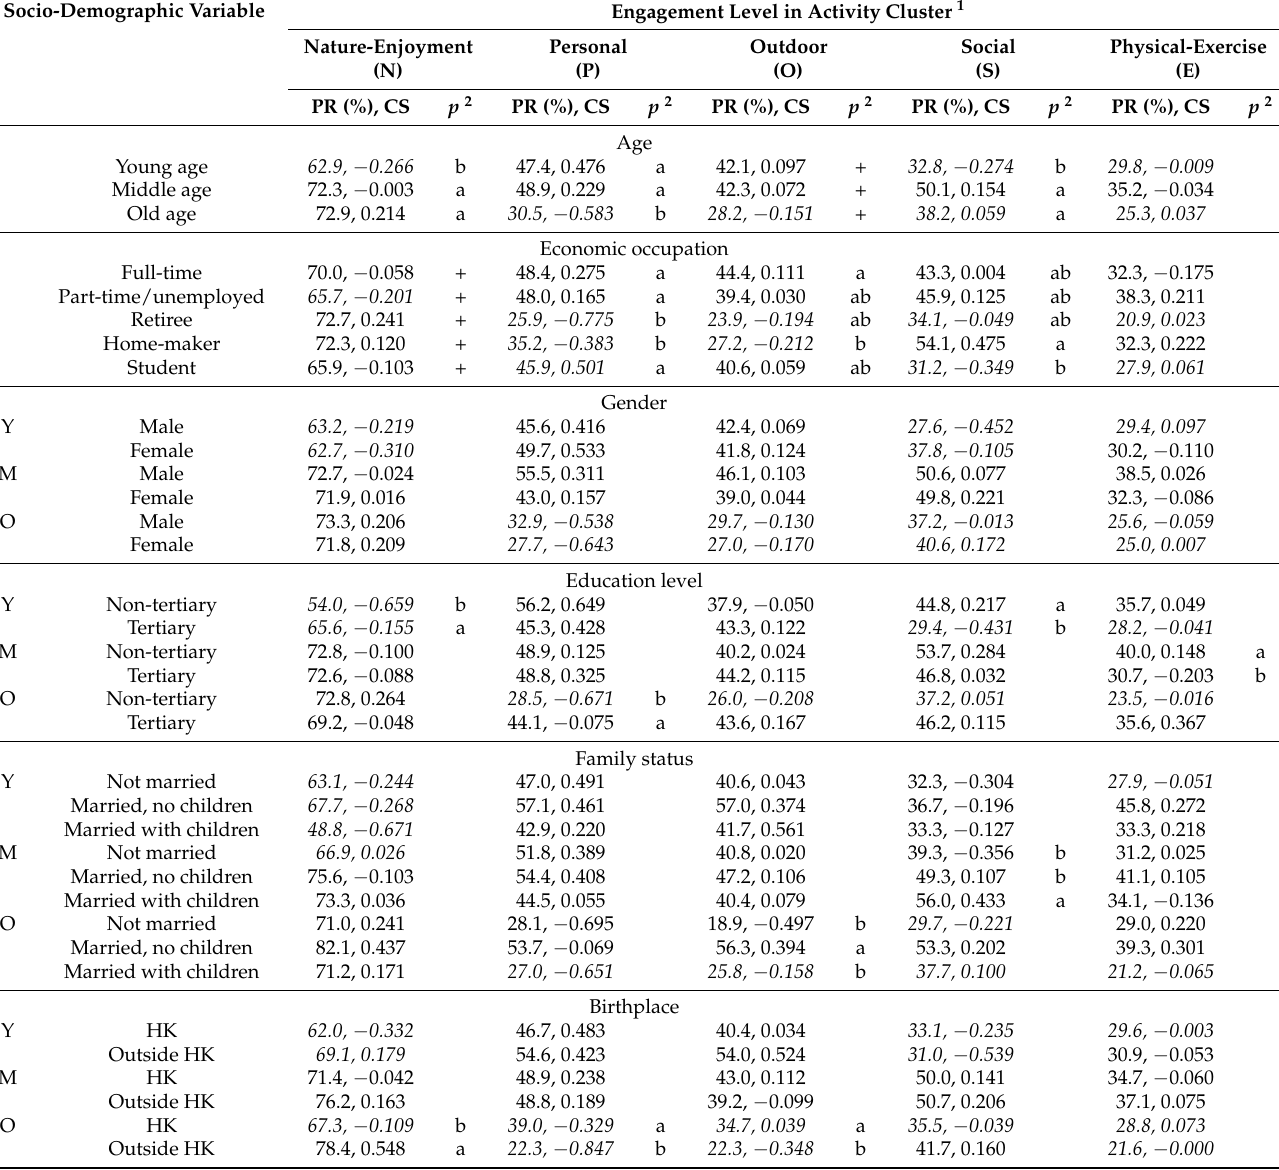
Table 4. The engagement level in five activity clusters in terms of average participation rates (PR) and PCA component scores (CS), by respondents’ six socio-demographic